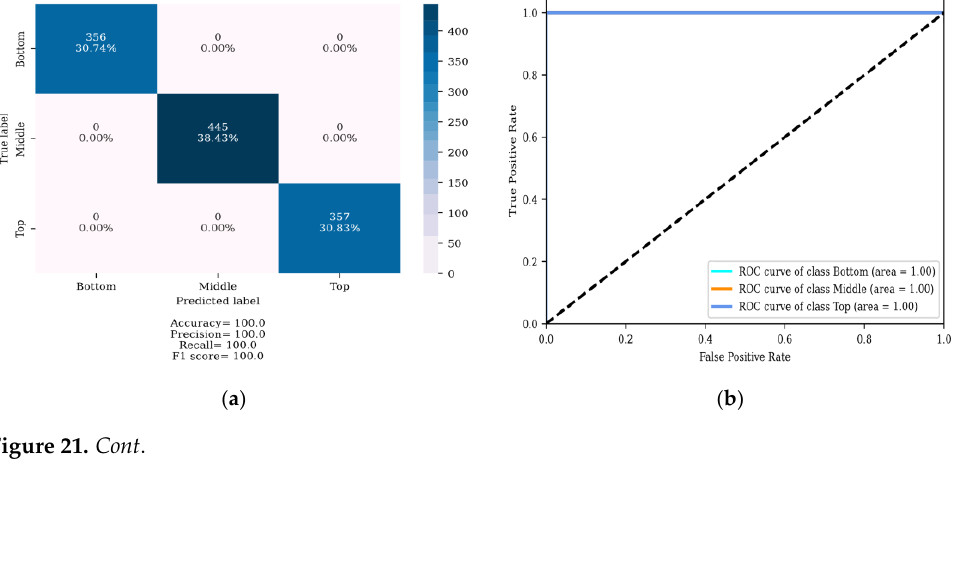
MLP and GMDH models have the maximum average accuracies in localization of the DSV fault when trained with the extracted features from the real part of the TF by the NRMSD index. Figures 21 and 22 show the training, validation, and test confusion matrices and ROC curves. The confusion matrix provides accuracy, precision, recall, and F1-score values. A box plot of the training, validation, and test accuracies in the thirty iterations is also provided.